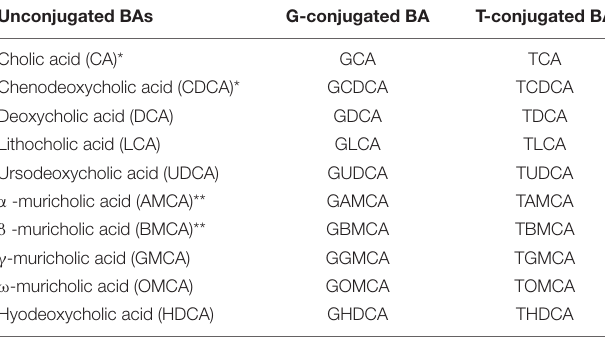
TABLE 1 | Unconjugated bile acids (BA) and C-6 hydroxylated muricholic bile acids (MCA) and their glycine (G) or taurine (T) conjugates analyzed in this study